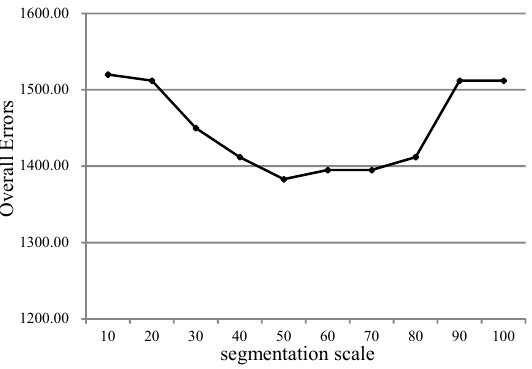
Figure 10. Overall errors of the change detection with different segmentation scales, with L2 as the basis image in the first study area. Table 5. Comparison between the change detection results of the single-scale and multi-scale proposed method, with L2 as the basis image in the first study area.